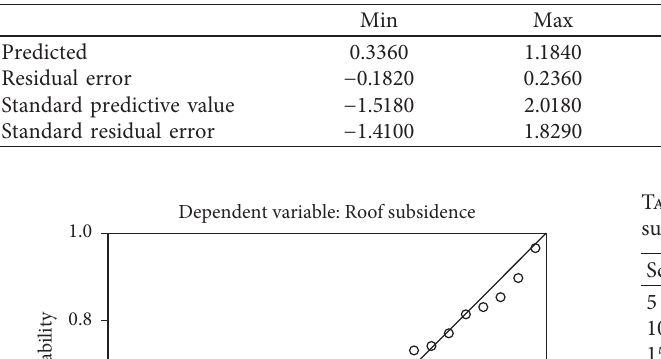
Table 11: Residual statistics.